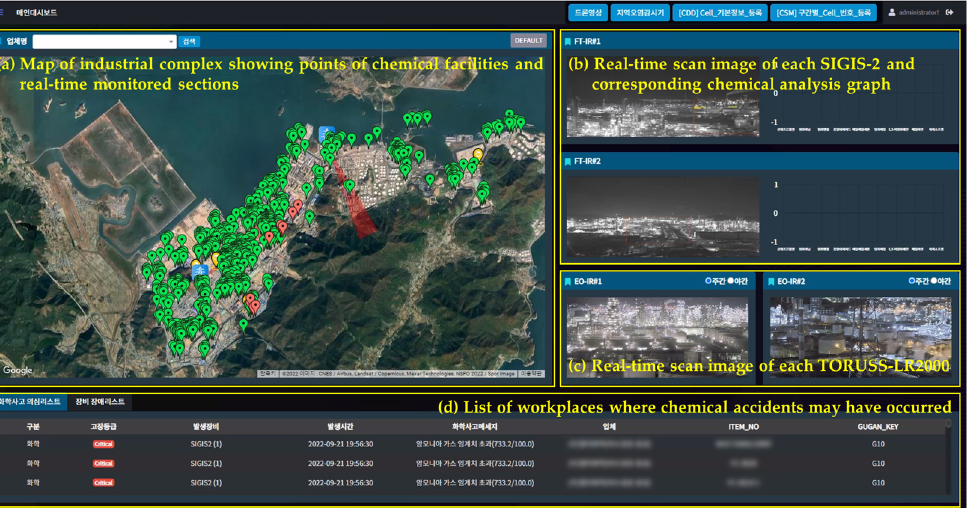
Figure 8. Main screen of the monitoring software. (a) Map of industrial complex showing points of chemical facilities and real-time monitored sections. (b) Real-time scan image of each SIGIS-2 and corresponding chemical analysis graph. (c) Real-time scan image of each TORUSS-LR2000. (d) List of workplaces where chemical accidents may have occurred.